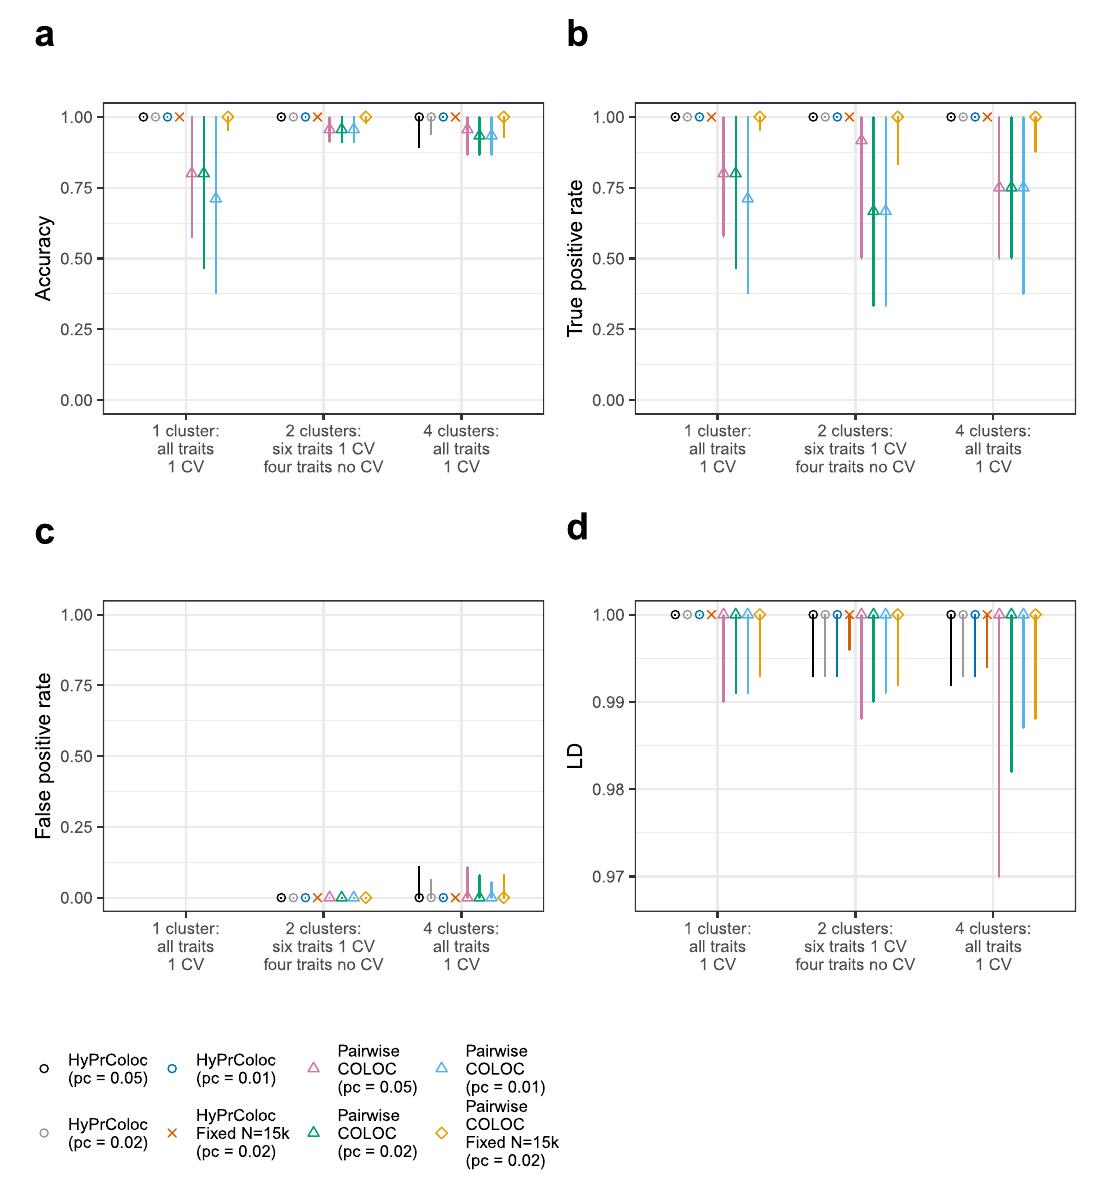
Fig. 6 Performance of the BB clustering algorithm when excluding clusters of colocalized traits with lower posterior probability. In each of the three scenarios presented, m = 10 traits with non-overlapping samples were generated, trait sample sizes were drawn randomly from the set N = {1,000, 5,000, 10,000, 15,000, 20,000} and variant-level causal con fi guration priors were used with three choices of the colocalization prior p c ∈ {0.05, 0.02, 0.01}. In scenario (i) there is one cluster of 10 colocalized traits; in scenario (ii) there are 2 clusters of colocalized traits, each comprising of 3 traits, the remaining 4 traits do not have causal variants and; in scenario (iii) there are 4 clusters of colocalized traits, 2 clusters of 3 traits and 2 clusters of 2 traits sharing a causal variant. Traits within a cluster share a single causal variant and causal variants between clusters are distinct, however, a distinct variant can be in perfect LD, i.e. r 2 = 1, with another distinct variant. In all scenarios, we present results that passed the posterior probability of colocalization P R P A ≥ 0.7. Presented are the classi fi cation measures: a accuracy; b true positive rate; and c the false positive rate. See ‘ Methods ’ for a description of how we de fi ne these in the context of clusters of colocalized traits. In d we present the LD between the identi fi ed causal variant for each cluster of colocalized traits and the true causal variant for each cluster. Error bars denote the 1st and 9th deciles and a point denotes the median value. The results highlight that on increasing the posterior threshold from 0.5 (c.f. Supplementary Fig. S2) to 0.7, HyPrColoc ’ s ability to cluster multiple traits together demonstrably improves accuracy and the true positive rate relative to pairwise correlation when setting the con fi guration prior probabilities; (b) probabilities: the posterior probability of colocalization between adjusting for correlation between the summary data in the the truly colocalized traits in scenario (b), which ignored known computation of the likelihood only; and (c) adjusting for correlation when setting the con fi guration prior, was signi fi cantly correlation in the computation of the likelihood and accounting smaller than in scenario (c) - leading to a single large cluster of for known trait correlation when setting the con fi guration prior colocalized traits being split into smaller clusters (Supplementary probabilities. Our fi ndings suggest that analyses which account Fig. S11 and Supplementary Table S2). Our results indicated that for correlation in the computation of the likelihood should also scenario (a), i.e. ignoring all correlation by treating studies as account for any known trait correlation in the con fi guration prior independent and traits as a-priori exchangeable, even when there